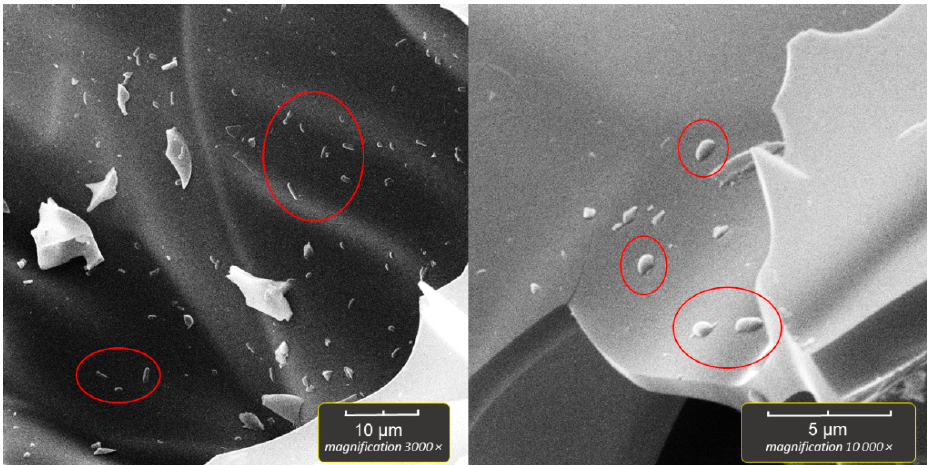
Figure 8. SEM image of bacteria immobilized on perlite in an experimental setup without aeration (anaerobic) and with Pruned Biomass (PB) consortium.